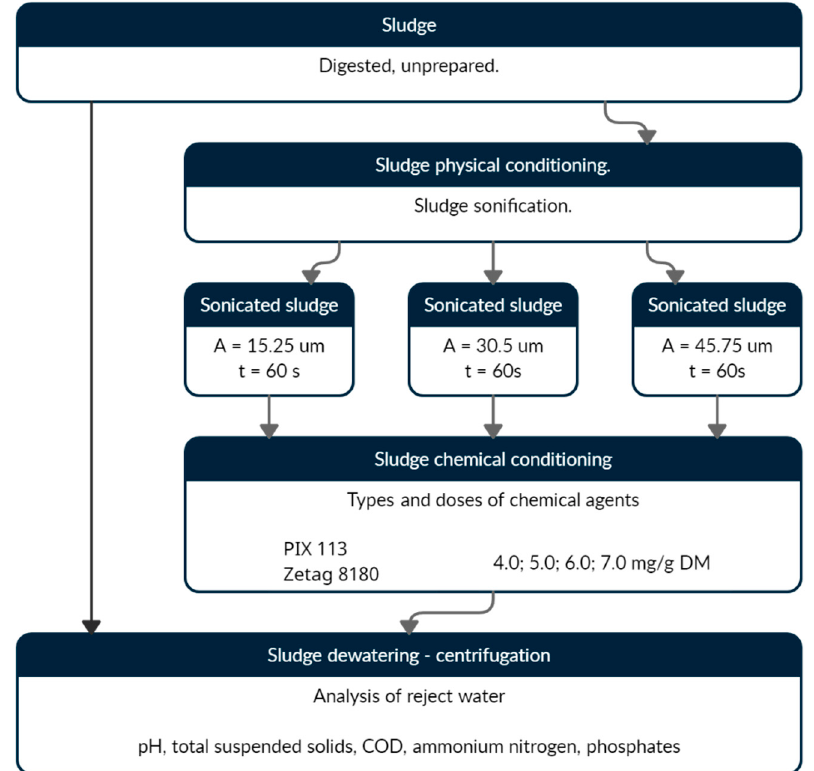
Figure 1. The scheme of the experimental research.